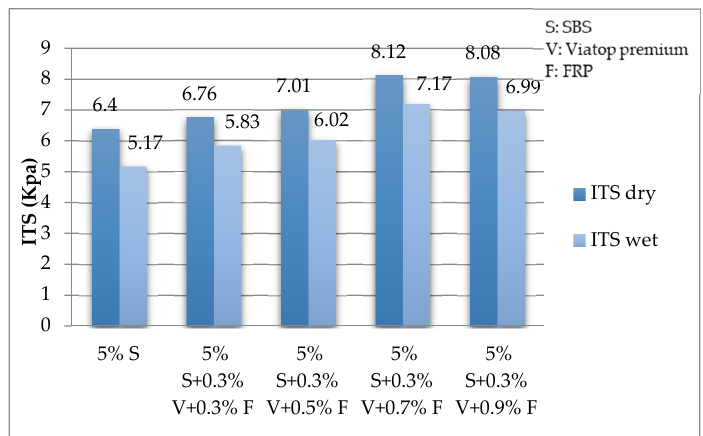
Figure 4. Results of Moisture damage test.